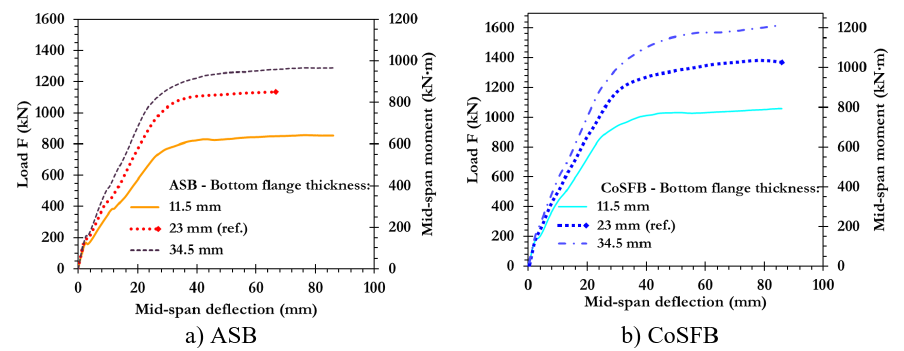
Figure 22. Load-deflection curve – Bottom flange thickness.